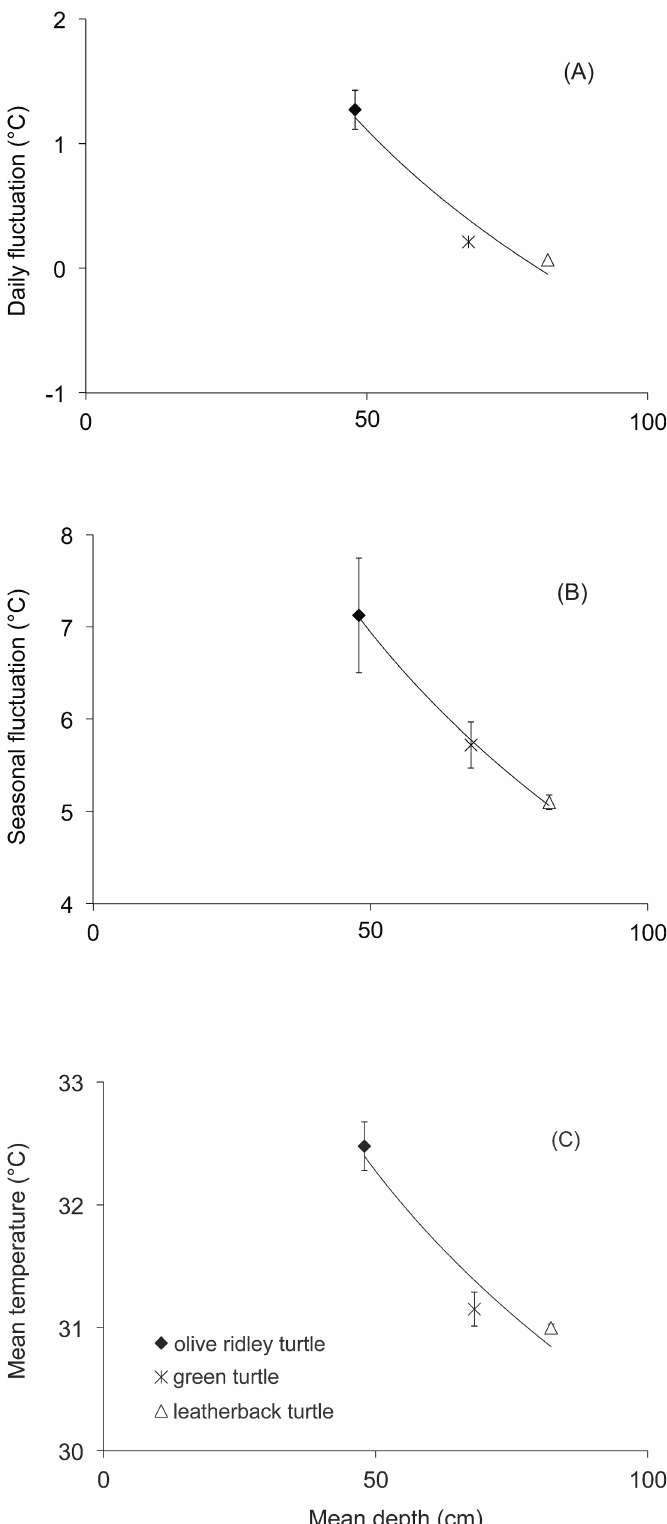
Fig 2. Thermal conditions in olive ridley, green and leatherback turtle clutches versus nest depth. (a) mean ( ± SE) daily fluctuationin temperature (˚C), (b) mean ( ± SE) seasonalfluctuation (˚C) and (c) mean ( ± SE) temperature (˚C) duringdevelopment. Regressionline corresponds to a logarithmic fit. https://doi.org/10.1371/journal.pone.0177256.g002 PLOS ONE | https://doi.org/10.1371/journal.pone.0177256 May 18,